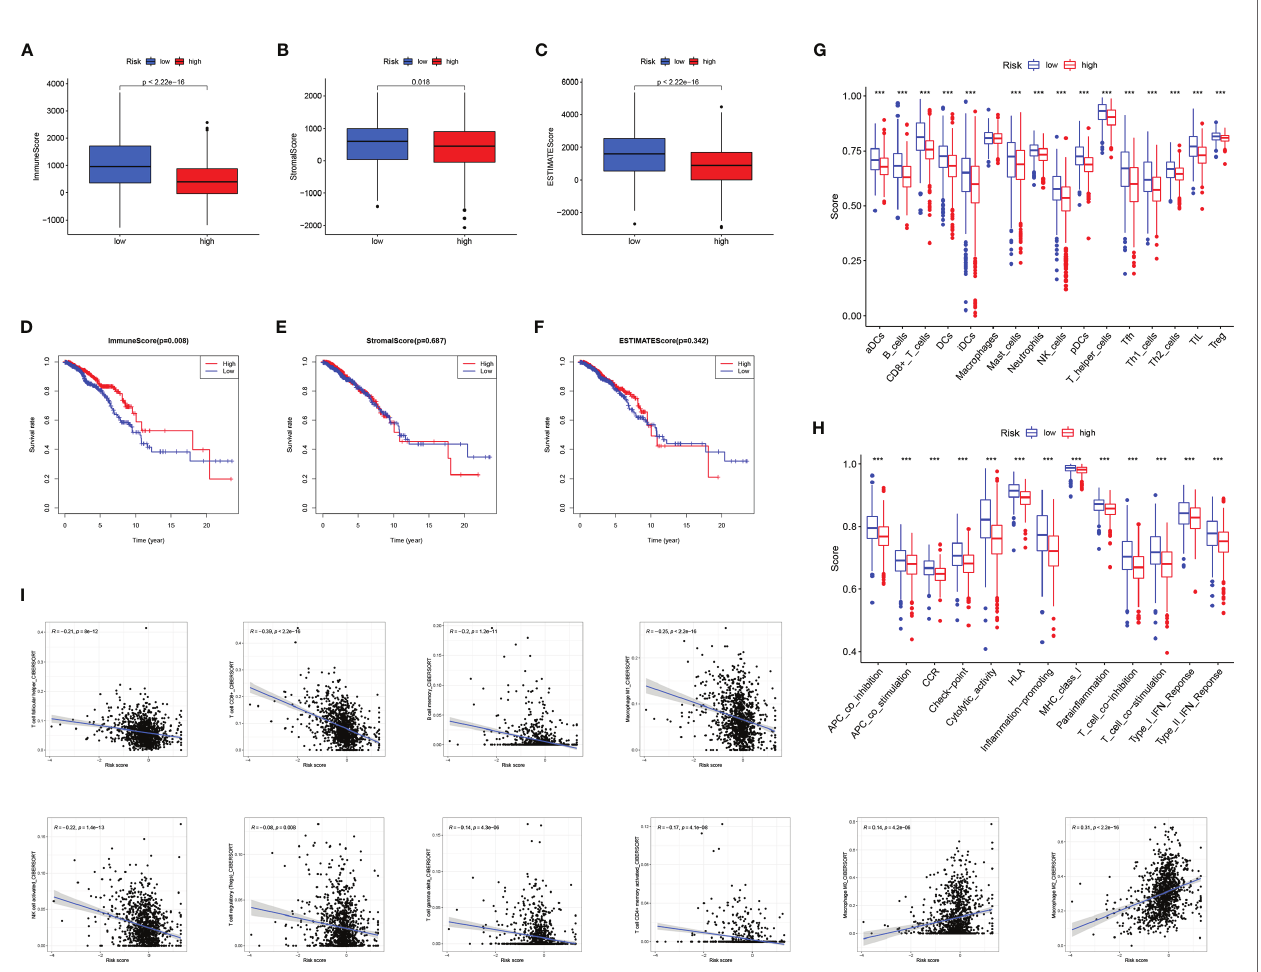
FIGURE 8 | The relationship between RS and tumor microenvironment. Comparison of the immune score (A) , stromal score (B) , estimate score (C) in high- and low-RS groups. Relationship between immune score (D) , stromal score (E) , estimated score (F) , and BC prognosis. Enrichment analysis of immune cell in fi ltration (G) and immune-related pathways (H) in high- and low-RS groups. (I) Correlation analysis of immune in fi ltrating cells and RS. *** P <